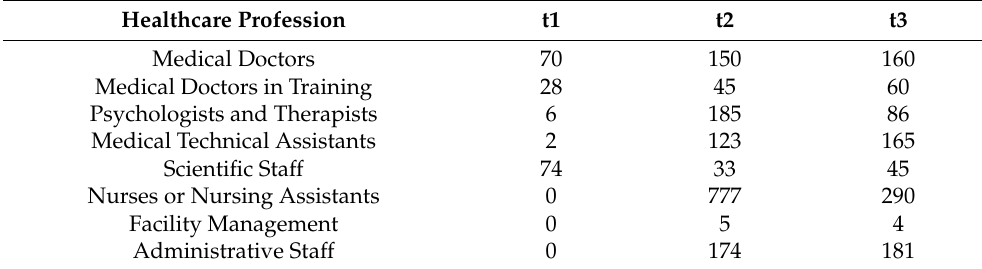
Table 2. Professions of the Healthcare Workers in both samples.